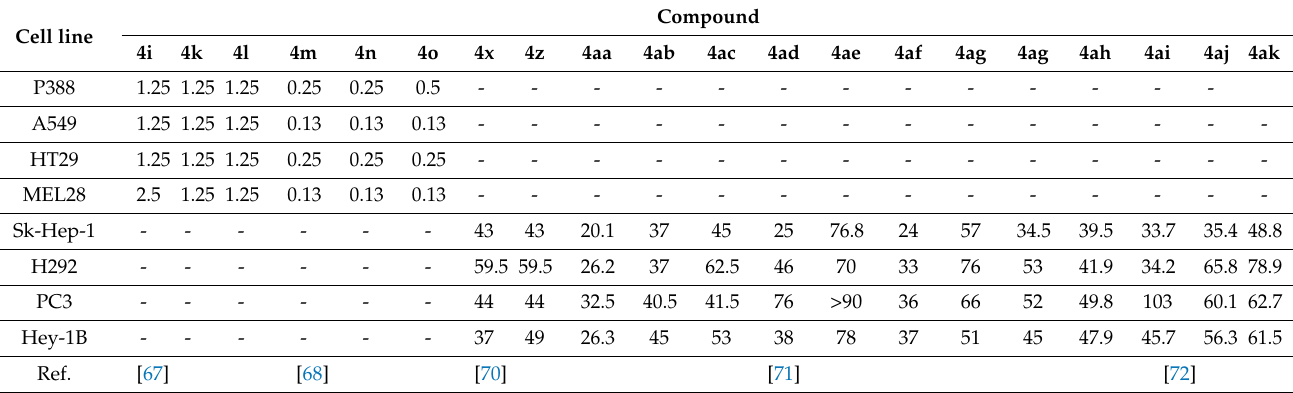
Table 5. IC 50 values ( µ g/mL) of the synthesized cholestane oxime